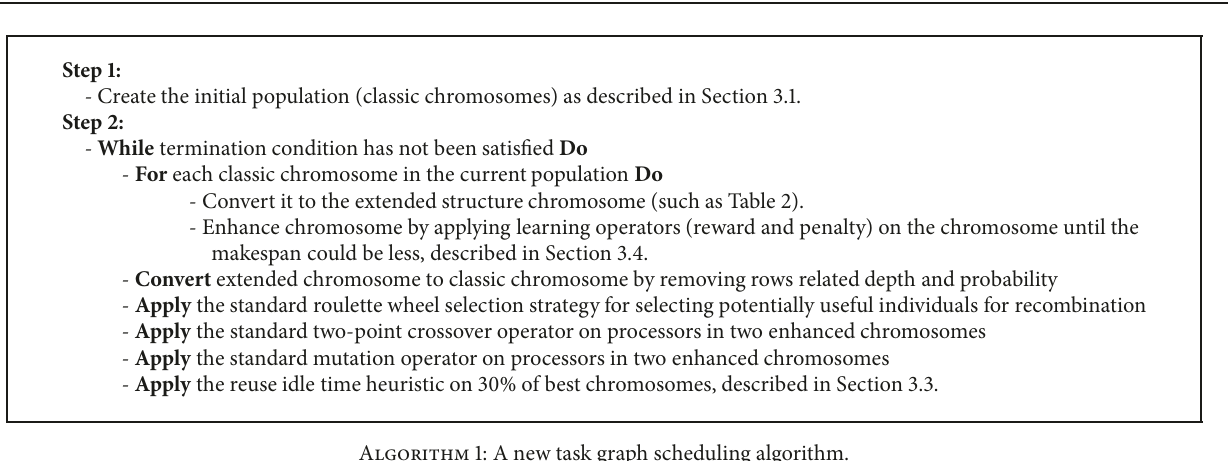
Algorithm 1: A new task graph scheduling